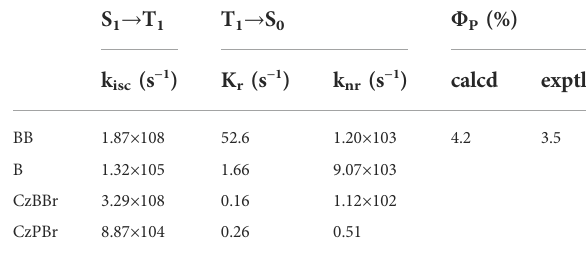
FIGURE 6 The distribution diagram of electron and hole.